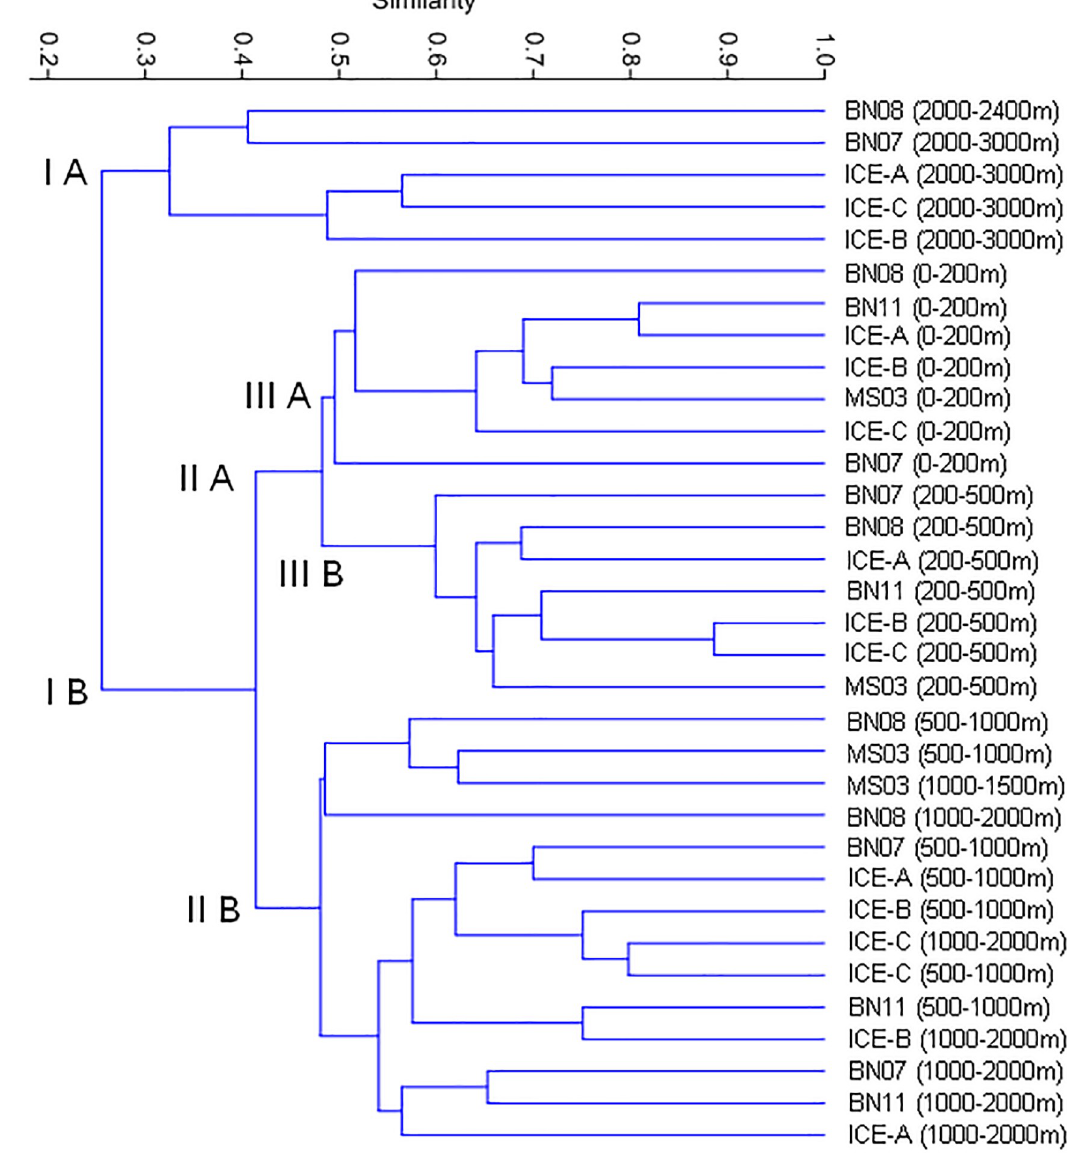
Fig 6. Clustering dendrogram of different samples by using Bray–Curtis similarities of copepod composition among 33 samples.